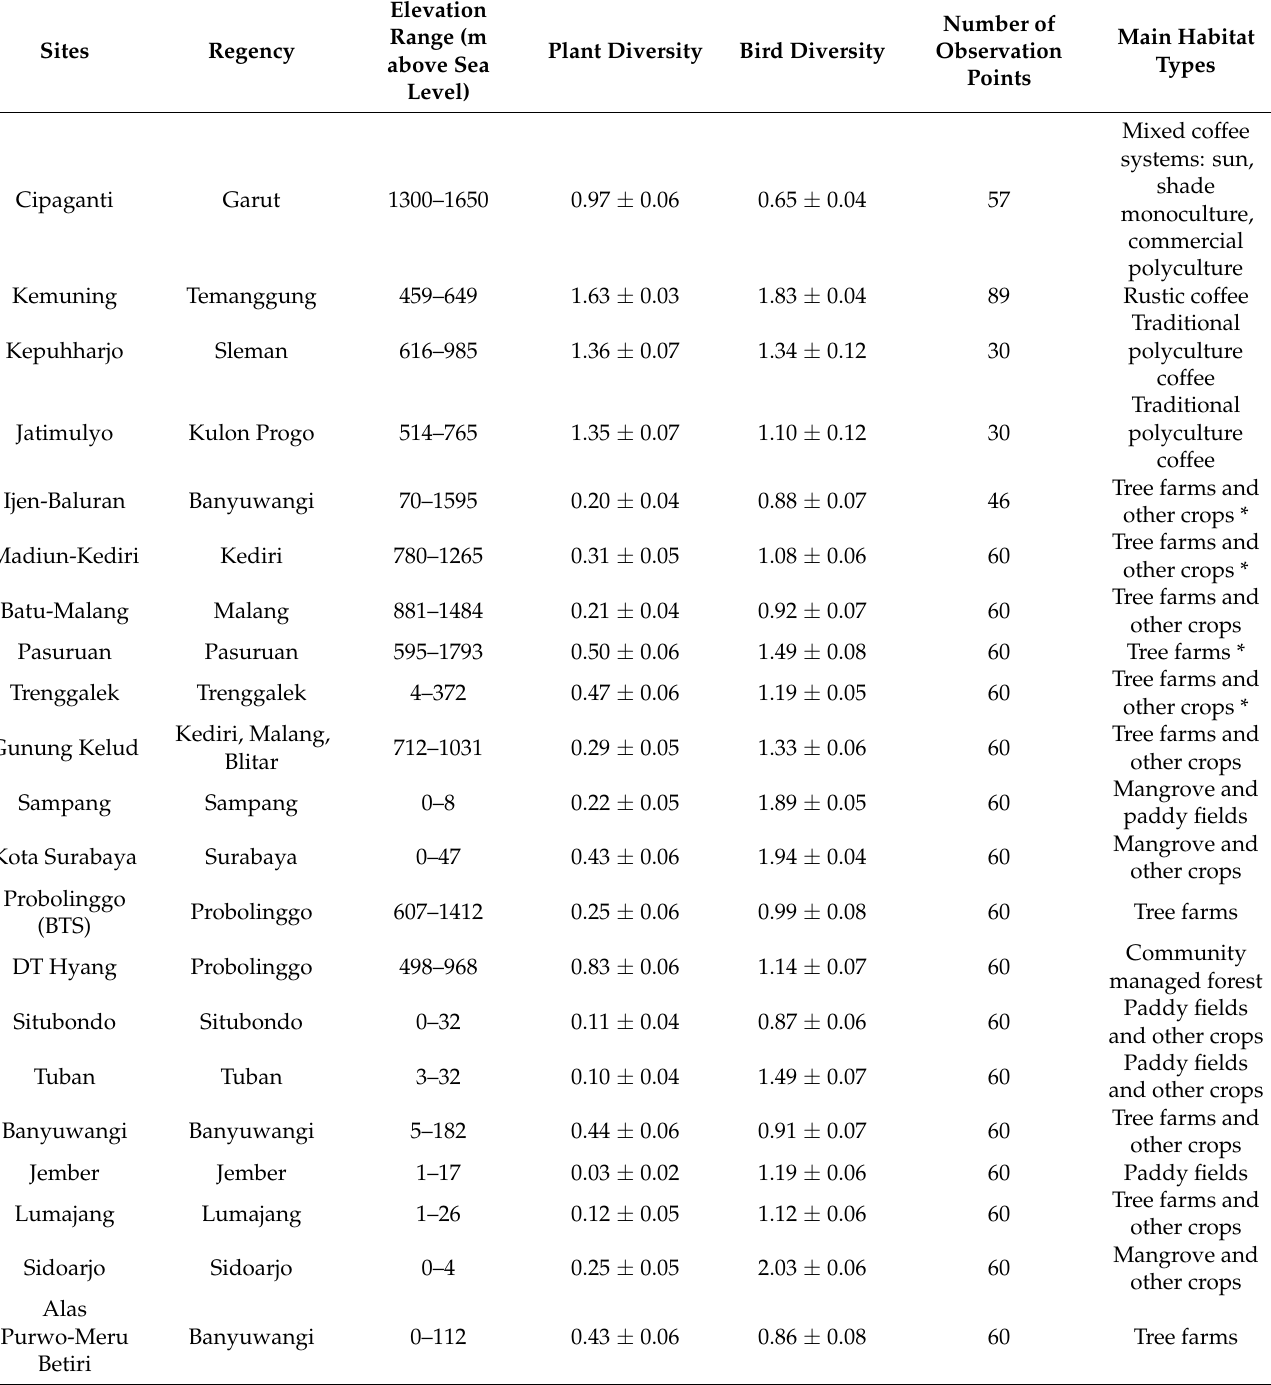
Table 1. Number of sampling points, elevation range, mean ( ± SE) plant diversity per plot, and mean ( ± SE) bird diversity per plot in the 21 study sites on